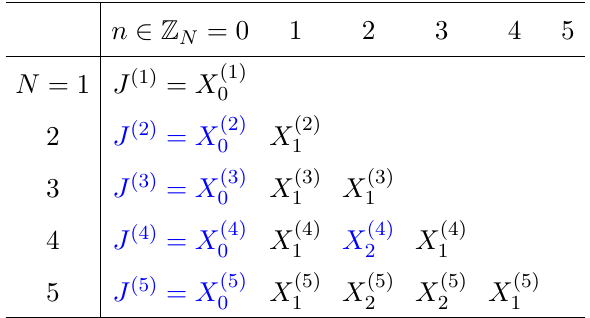
Table 1 . The geometries that are associated to the elements of the Z N Tate-Shafarevich group of representative generic torus fibered Calabi-Yau threefolds over P 2 with h 1 , 1 = 2 . Singular geometries are highlighted in